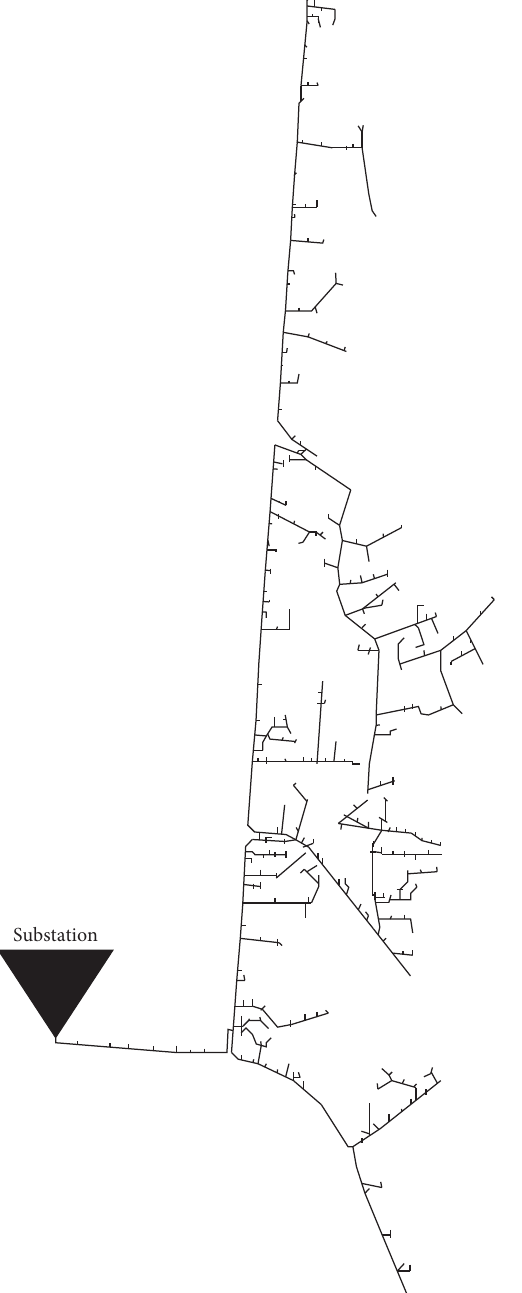
Figure 27: Network confguration of feeder no.